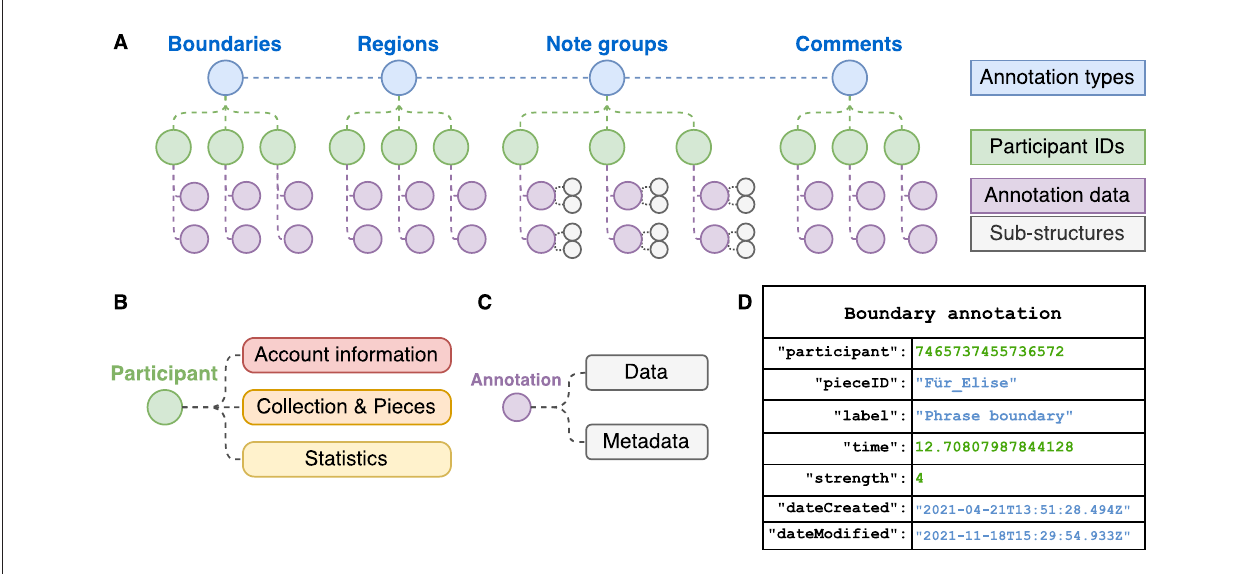
FIGURE 10 | Data structure for the CosmoNote Annotations as organized in json objects. (A) A representation of nested data in each of the four annotation types; (B) A participant object contain information about its Account, Collection & Pieces, and aggregated Statistics; (C) Annotation objects contain data (e.g., timestamps, labels) and metadata (e.g., date of creation and last modification); (D) An example boundary annotation json